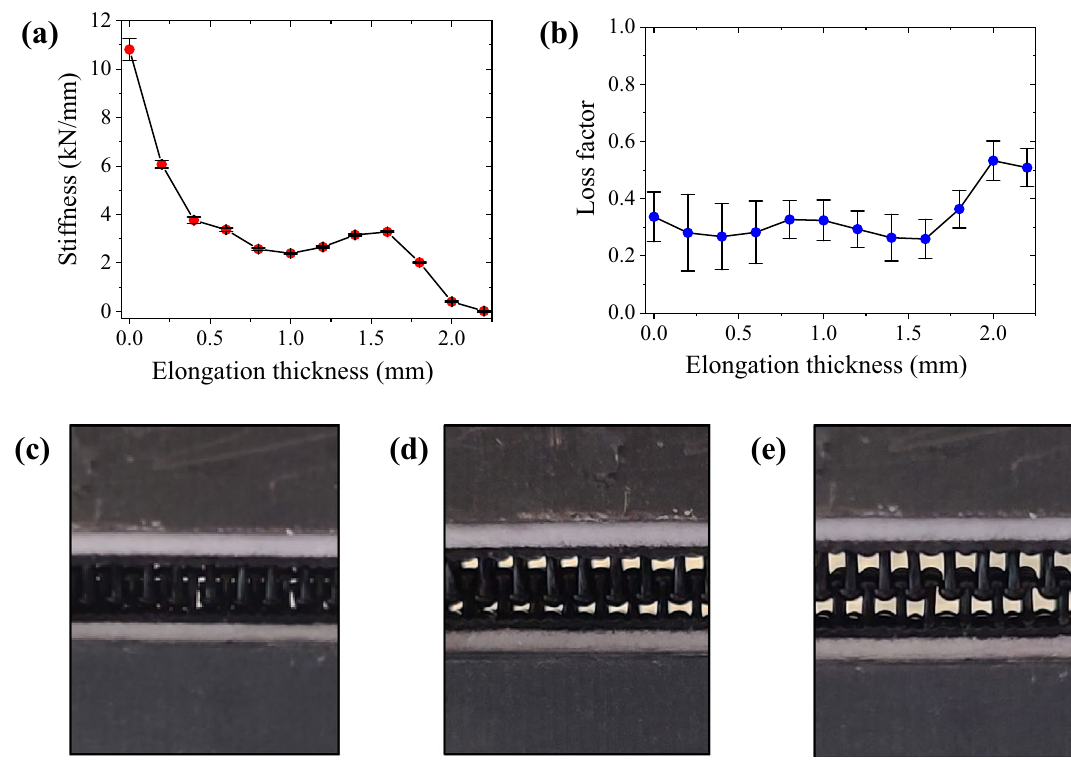
Figure 5. Dynamic properties of probabilistic fastener specimen, ( a ) stiffness and ( b ) loss factor. Specimen shape variations according to thickness variations: ( c ) 0 mm, ( d ) 1.0 mm, and ( e ) 1.6